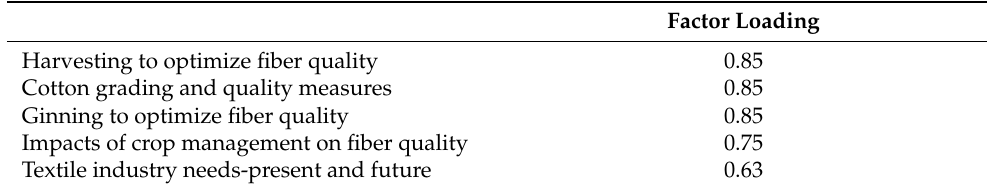
Table 22. Factor loading and importance items of fiber quality and post-harvest after factor rotation.